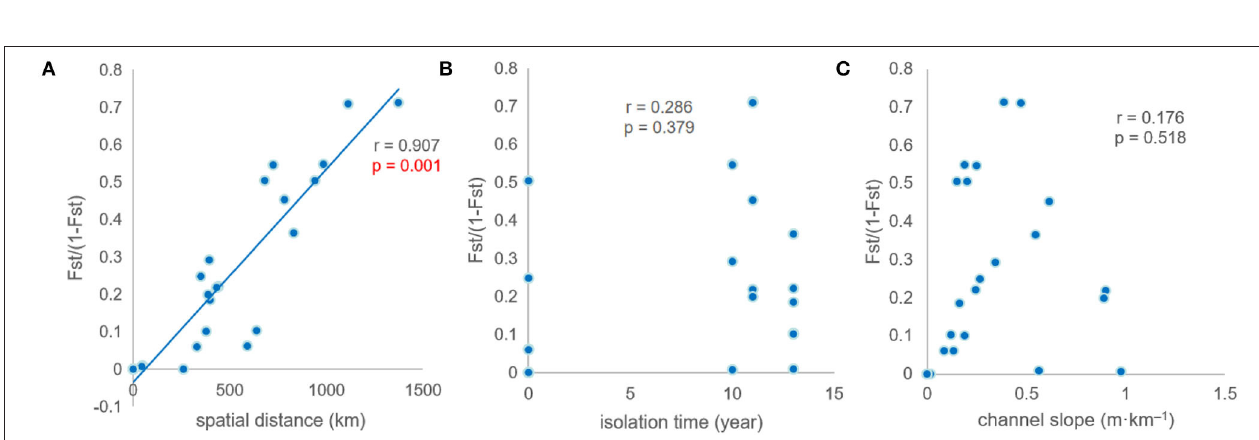
FIGURE 5 | Mantel tests between genetic differentiation and environmental factors. (A–C) r is correlation coefficient, p value is used to determine the result of hypothesis testing.